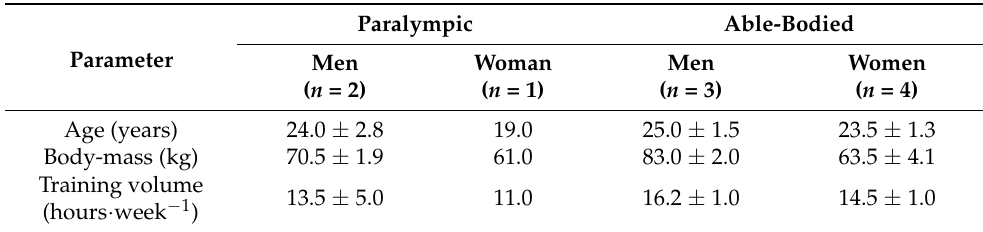
Table 1. Age, body-mass, and training volume (mean ± SD) of the three Para and seven able-bodied (AB) XC skiers included in the